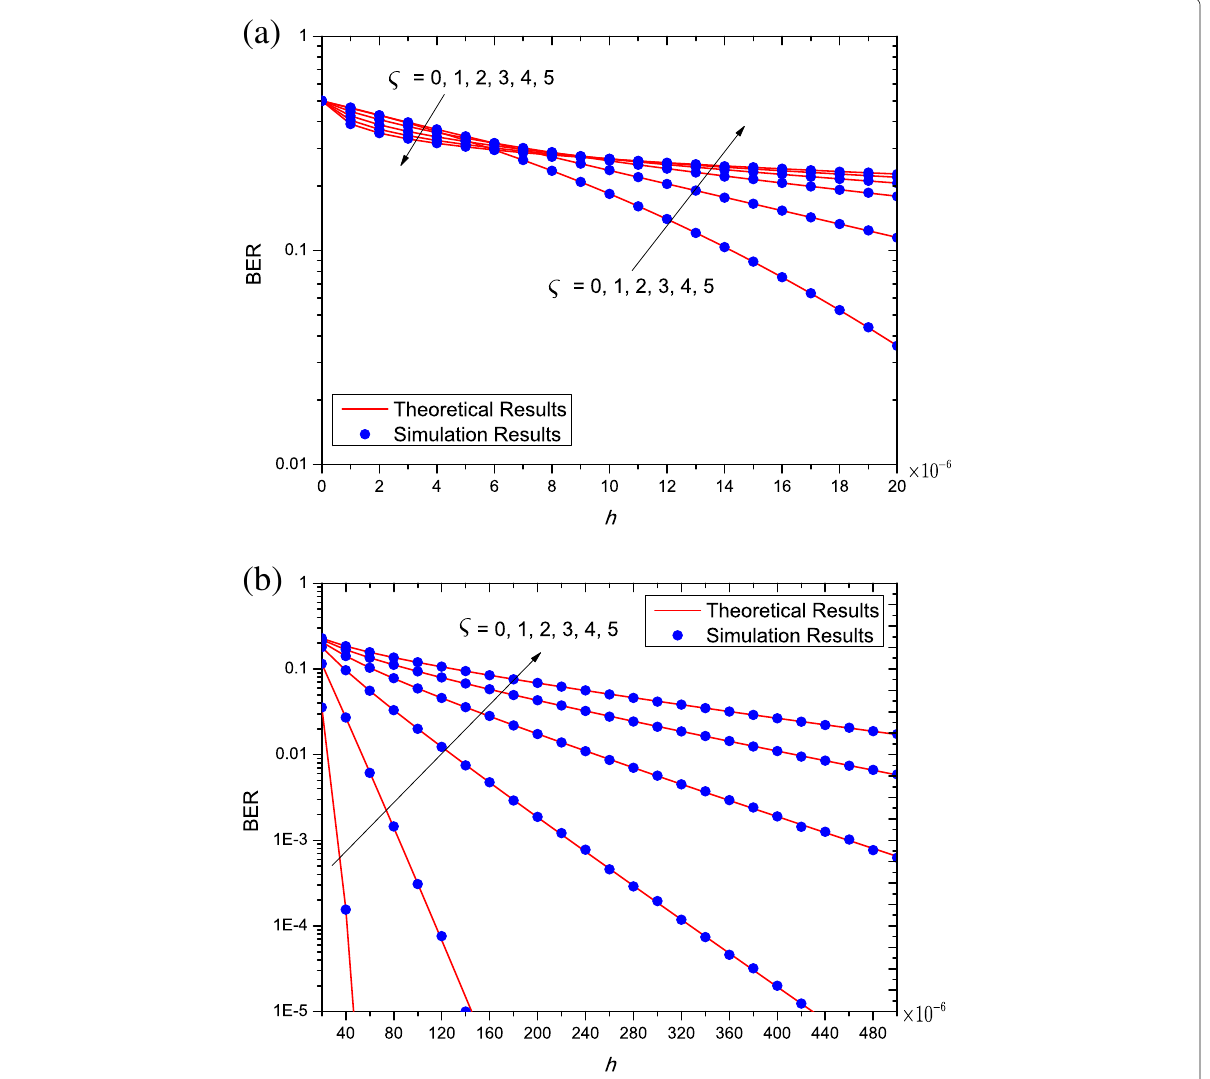
Fig. 6 BER versus channel gain h with different ς when P = 50 dBm. a BER with small h , b BER with large